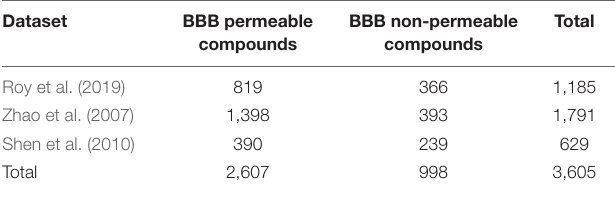
TABLE 1 | The final dataset and its distribution.